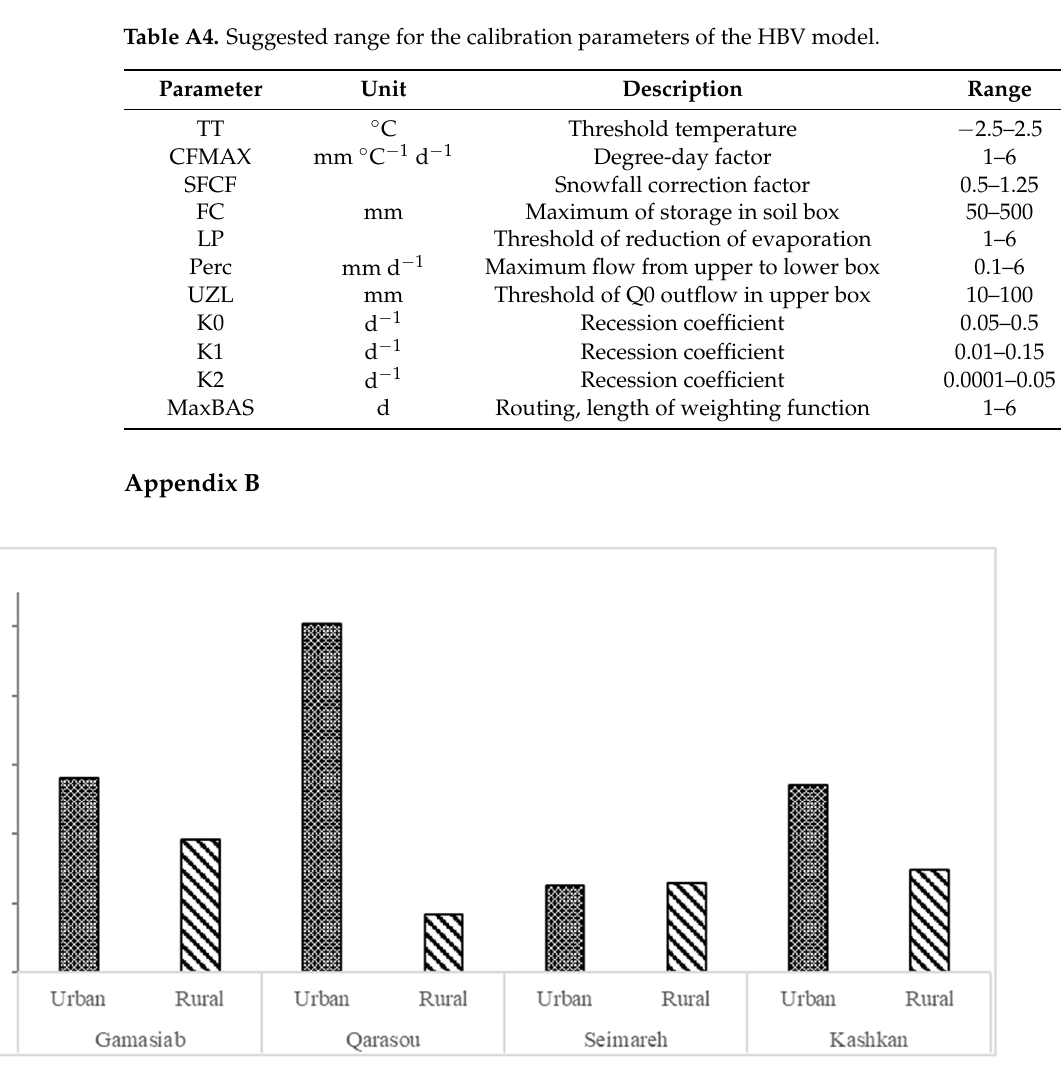
Figure A1. Approximated population distribution in the KRB based on the 2015 national record.